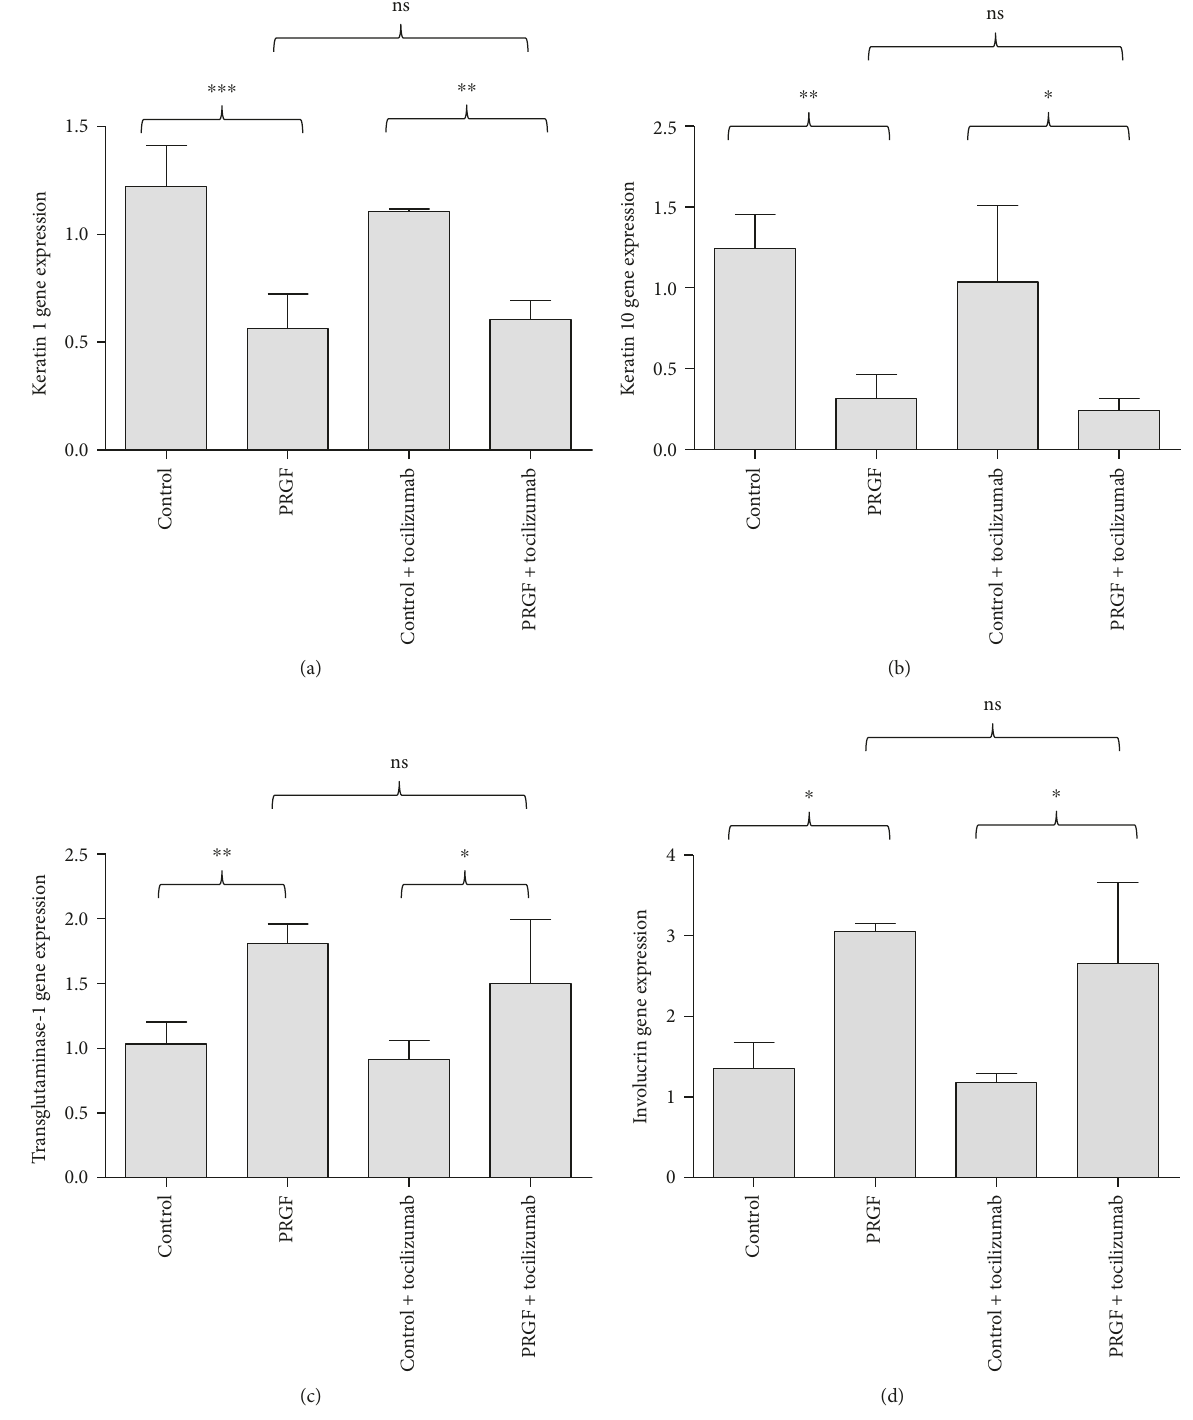
Figure 5: The IL-6 receptor is not involved in the PRGF-mediated modulation of di ff erentiation markers in keratinocytes. PRGF stimulation of primary human keratinocytes caused a reduced keratin 1 and keratin 10 gene expression and an induced transglutaminase-1 and involucrin gene expression. Costimulation with the IL-6 receptor-blocking antibody tocilizumab revealed that these e ff ects were not mediated via the IL-6 receptor (real-time PCR analysis, ∗ P < 0 05 , ∗∗ P < 0 01 , ∗∗∗ P < 0 001 , ns=not signi fi cant, one-way ANOVA with Tukey ’ s multiple comparison